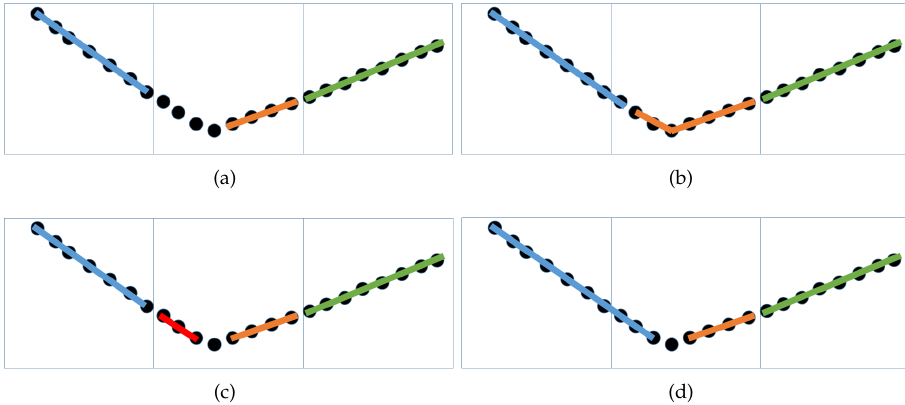
Figure 3. Edge information calculation. ( a ) Result after the coplanarity test. ( b ) An example of boundary problem. ( c ) Edge patch extraction. ( d ) Merging edge